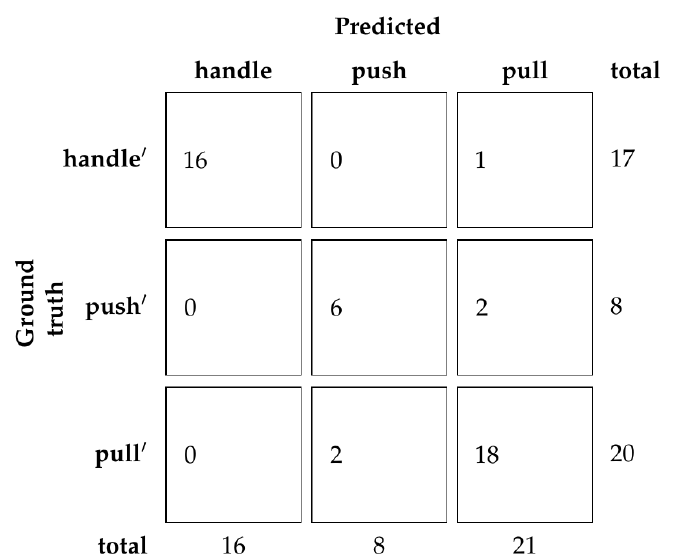
Figure 12. Confusion matrix of classification for the test set without human